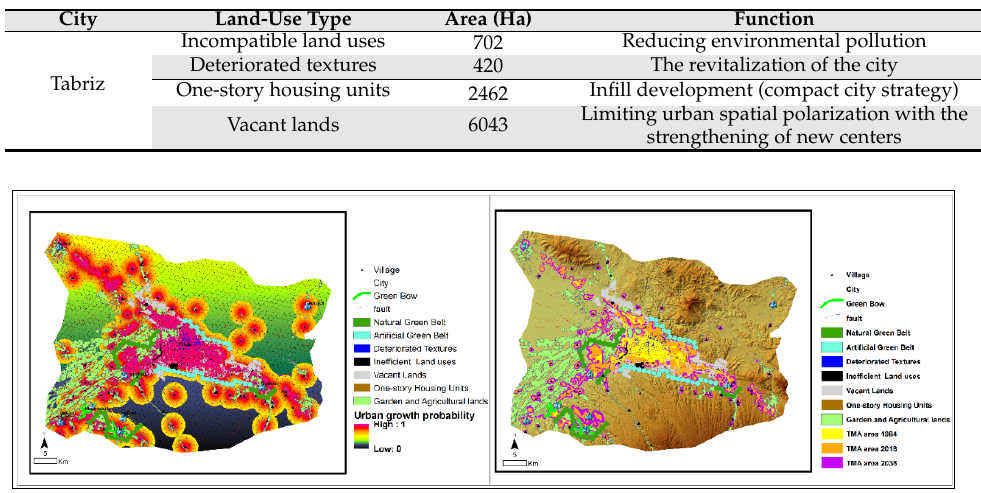
Figure 10. Left: extracting naturally based protective barriers (green belt and green bows) using hexagon blocking of the urban growth probability map for preservation of the ecological landscape in the TMA by 2038; right: simplified NB development in the TMA by 2038.